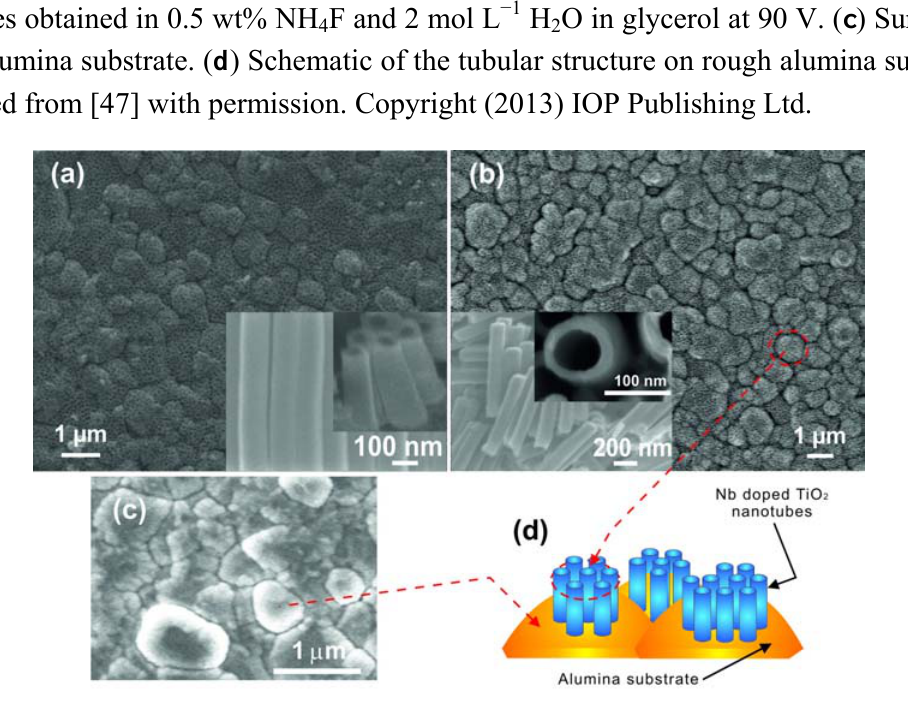
Figure 10. SEM images of ( a ) TiO substrates obtained in 0.5 wt% NH